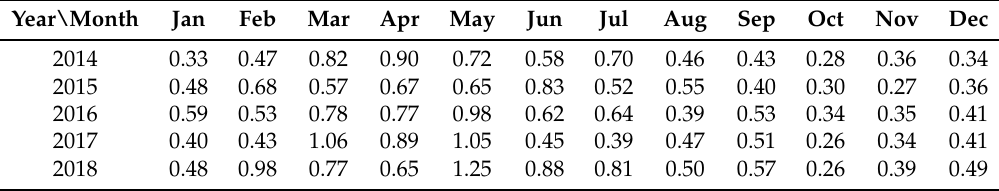
Table A8. Monthly standard deviations for surface salinity for the years